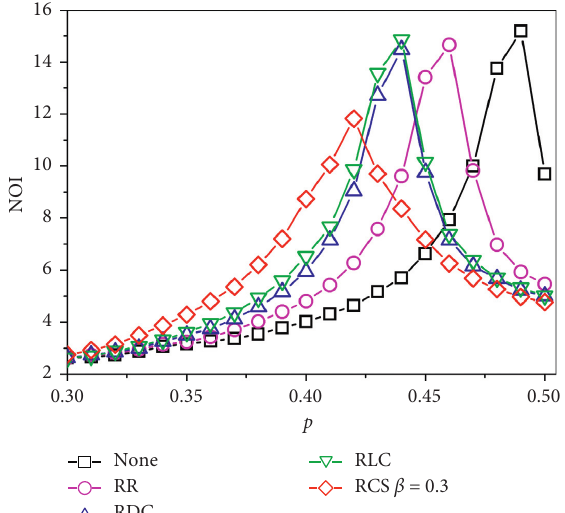
Figure 8: The number of iterative cascade steps (NOI) required for a network to reach the steady state as a function of the fraction of surviving nodes p on the ICNs with ER-ER